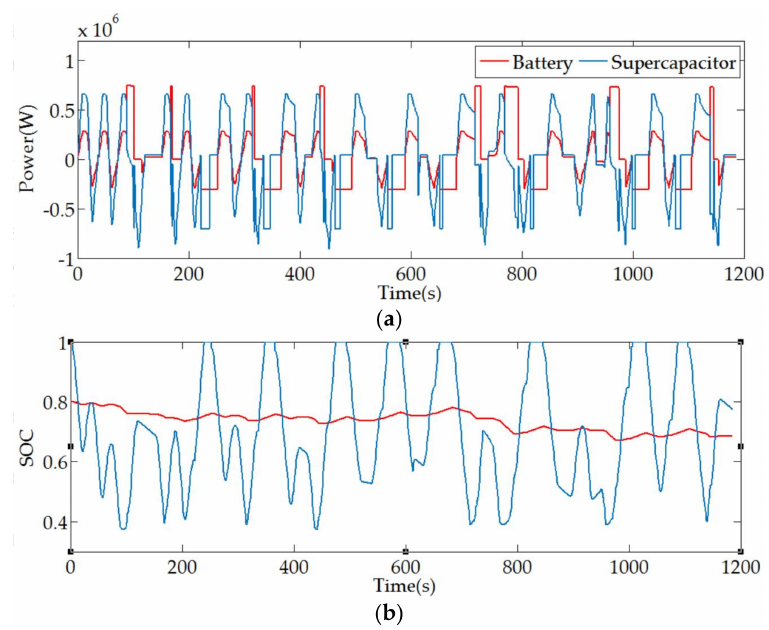
Figure 14. Simulation results. ( a ) Output power curves of the battery and the supercapacitor. ( b ) SOC curves of the battery and the supercapacitor.